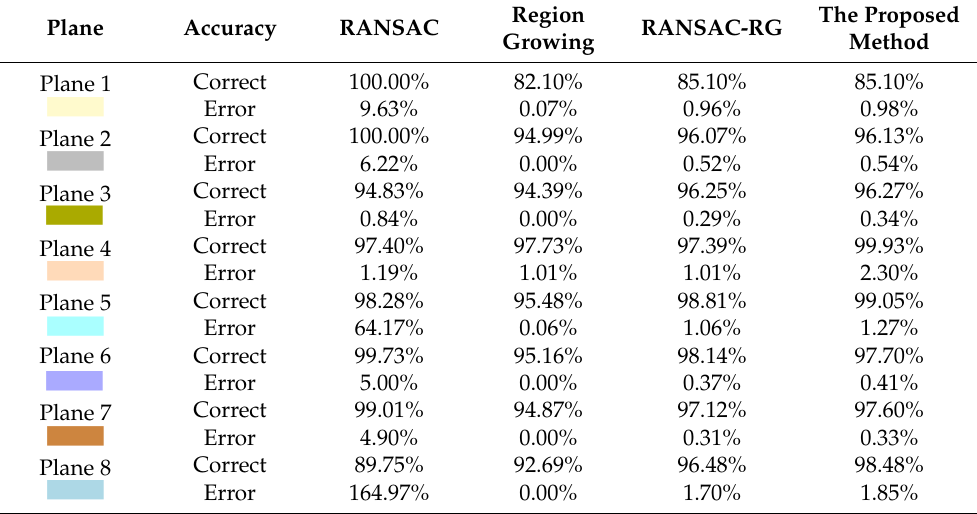
Table 4. Accuracy assessment of cottage’s plane segmentation.